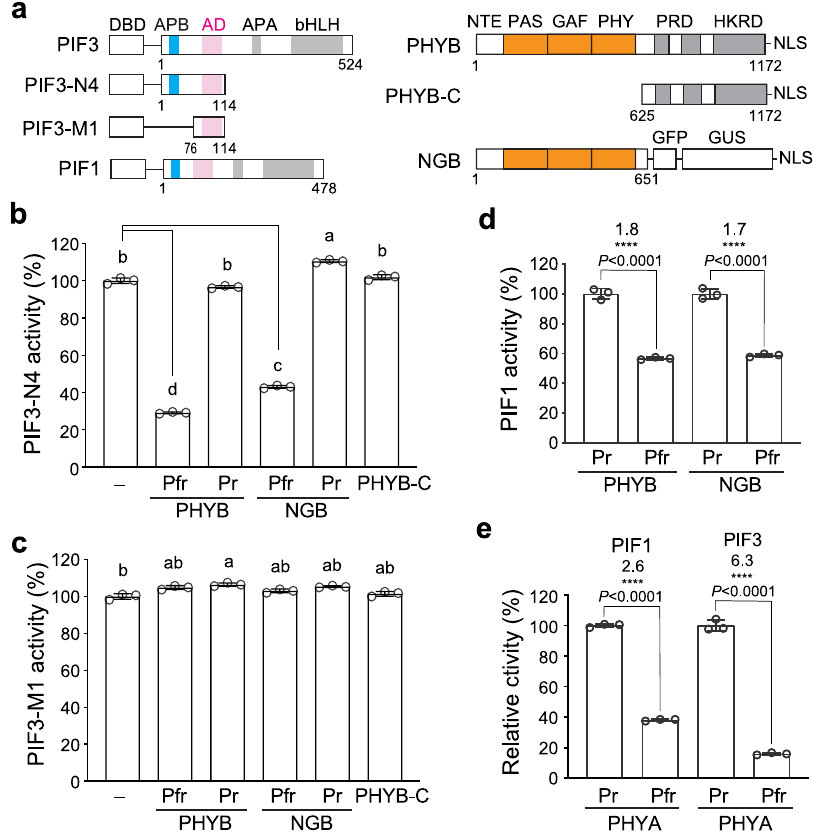
Fig. 7 Binding of either PHYB or PHYA inhibits the AD activity of PIF3 and PIF1. a Schematics of the PIF3, PIF1, and PHYB constructs used for determining the effect of PHYB binding to the transactivation activity of PIF3 and PIF1. NLS, nuclear localization signal. b Results of yeast liquid β - galactosidase assays showing the activity of PIF3-N4 expressed alone (-) or coexpressed with PHYB, NGB, or PHYB-C. c Results of yeast liquid β - galactosidase assays showing the activity of PIF3-M1 expressed alone (-) or coexpressed with PHYB, NGB, or PHYB-C. For b and c , The assays for PHYB and NGB were performed in either R or FR light to maintain PHYB and NGB in the Pfr or the Pr conformer, respectively. The transactivation activities were calculated relative to that of the yeast strains expressing the PIF3 fragments alone. Error bars represent the s.d. of three biological replicates. Samples labeled with different letters exhibited statistically signi fi cant differences (ANOVA, Tukey ’ s HSD, P ≤ 0.05, n = 3). d Results of yeast liquid β -galactosidase assays showing the activity of PIF1 coexpressed with PHYB or NGB. e Results of yeast liquid β -galactosidase assays showing the activity of PIF1 or PIF3 coexpressed with PHYA. For d and e , the assays for PHYB, NGB, and PHYA were performed in either R or FR light to maintain them in the Pfr or the Pr conformer, respectively. The transactivation activities were calculated relative to the assays when PHYs were in the Pr. The statistical signi fi cance was analyzed using two-tailed Student ’ s t -test (**** P ≤ 0.001); The numbers indicate fold changes in activity. Error bars represent the s.d. of three biological replicates. The centers of the error bars represent the mean values. The source data underlying the yeast liquid β -galactosidase assays in ( b ), ( c ), ( d ),